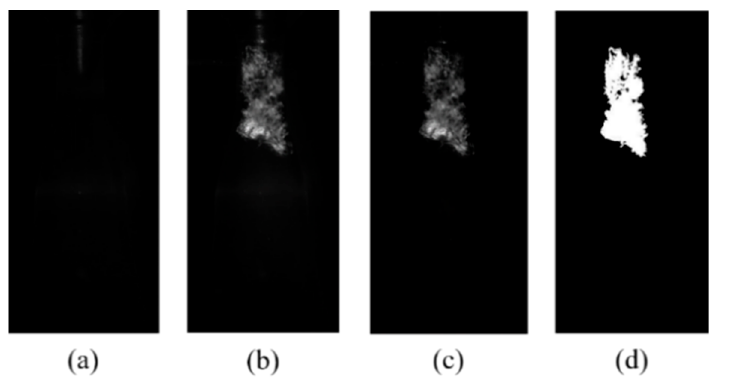
Figure 3. Operation flow chart of this experiment.